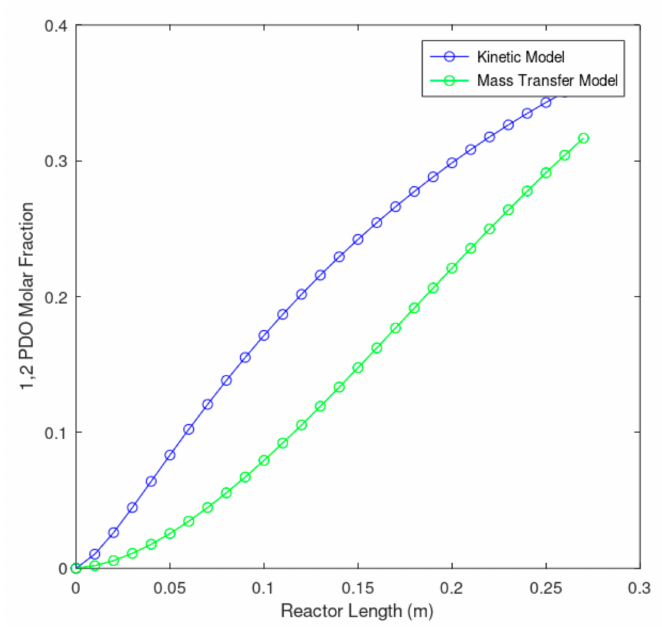
Figure 7. Comparison of 1,2 propanediol molar fraction with the kinetics model and with the mass transfer